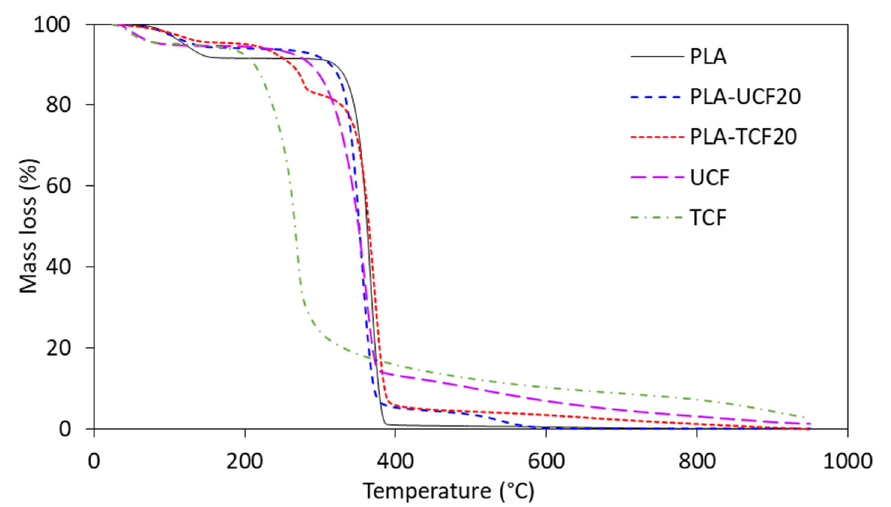
Figure 6. TGA curves of films and fibers with and without treatment.